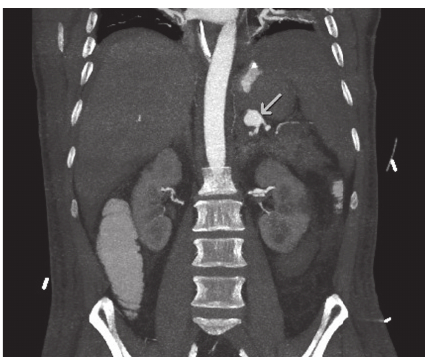
Figure 1: Splenic artery aneurysm (arrow) of 14mm on abdominal computed tomographic angiography.